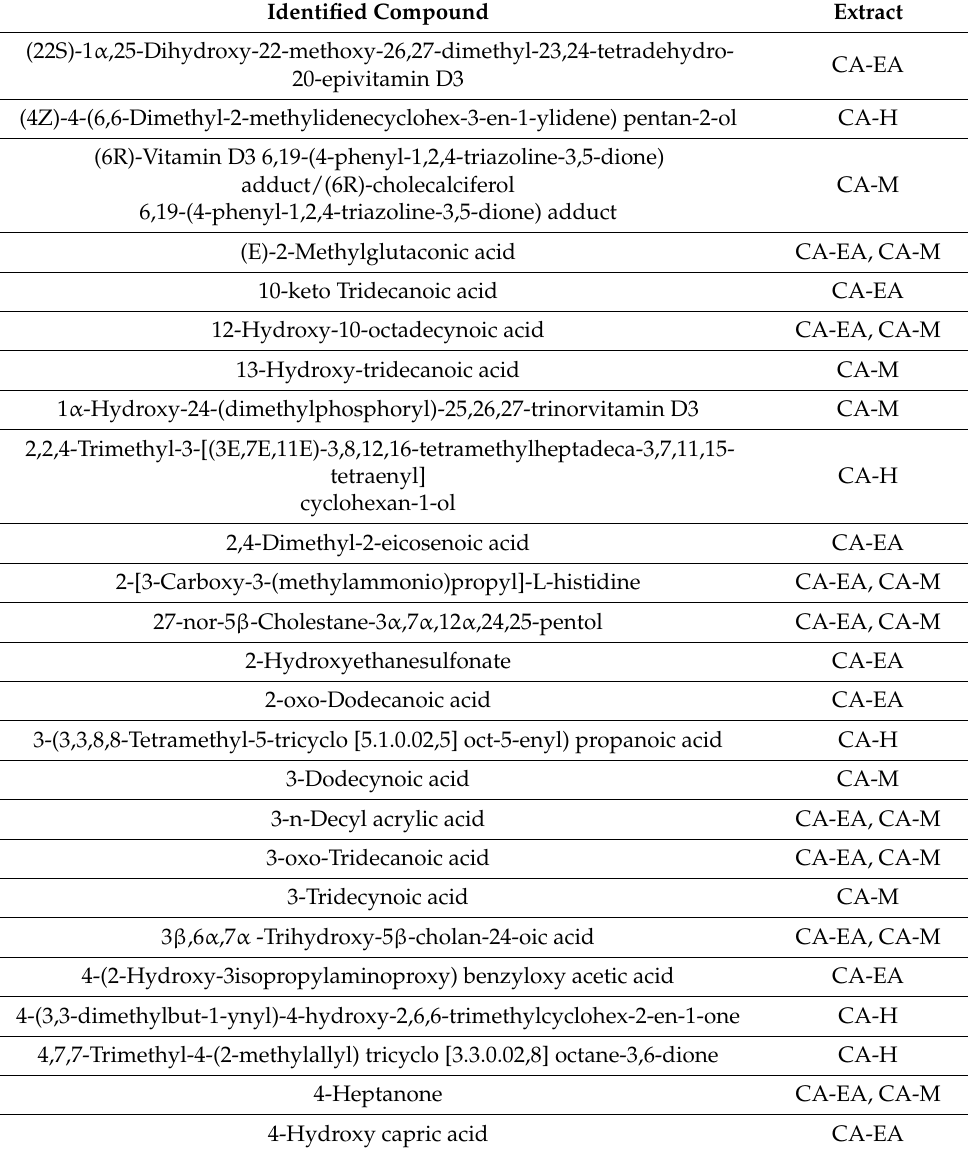
Figure 3. The Venn diagram shows numbers of compounds found in CA-H, CA-EA, and CA-M. Table 1. List of phytochemical compounds identified in CA extracts.